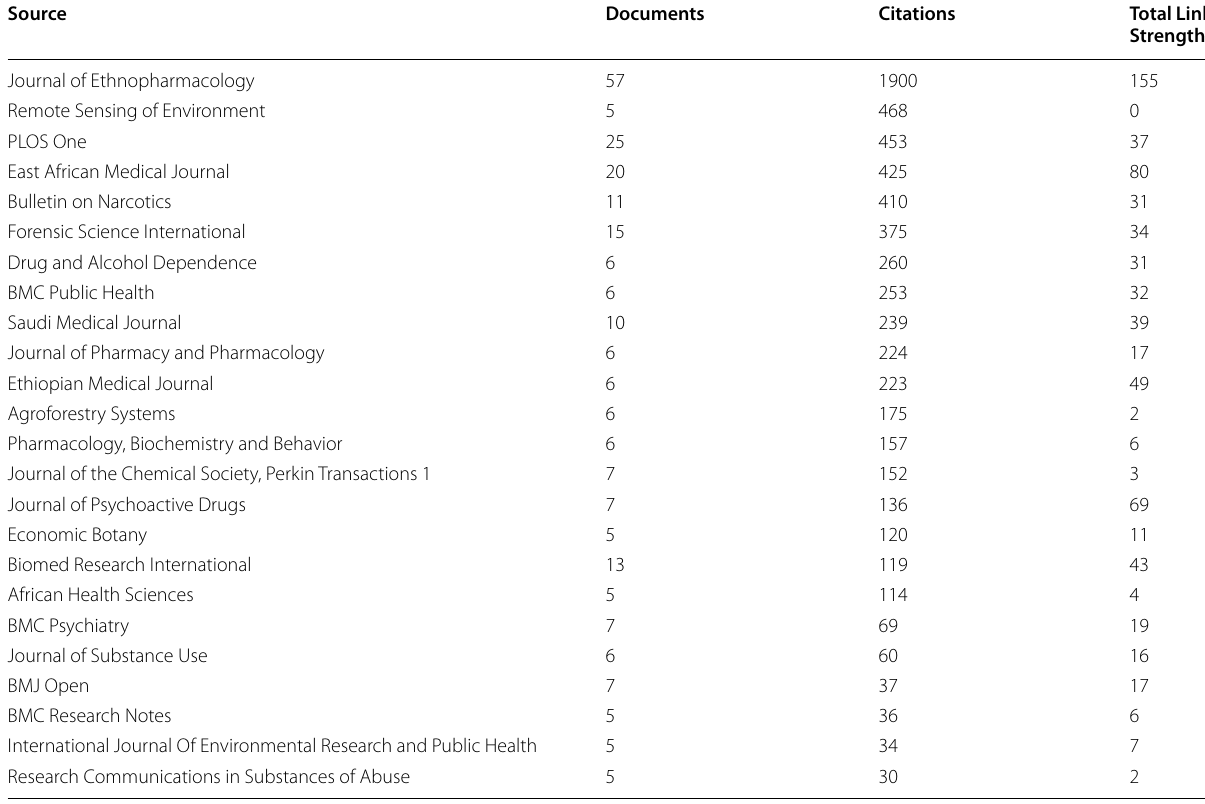
Table 2 Top-cited journals with the number of articles published on C. edulis